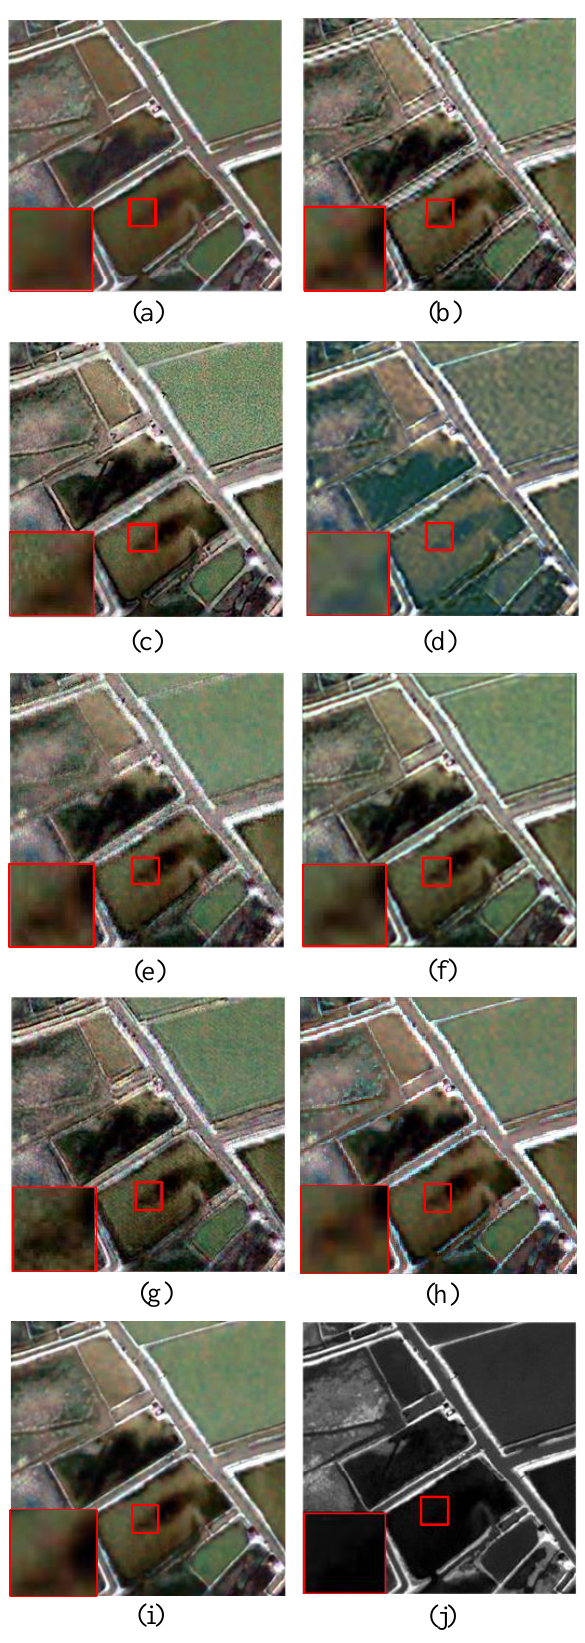
Figure 12. The real results on the QuickBird dataset. ( a ) GS. ( b ) Indusion. ( c ) SR. ( d ) PNN. ( e )